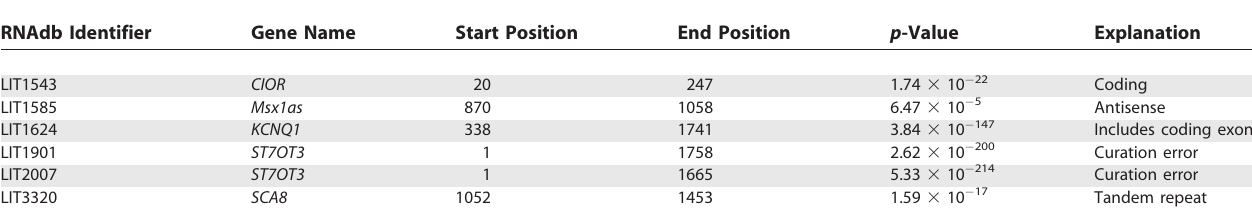
Table 4. CRITICA Predictions in Curated Non-Protein-Coding RNA Sequences RNAdb